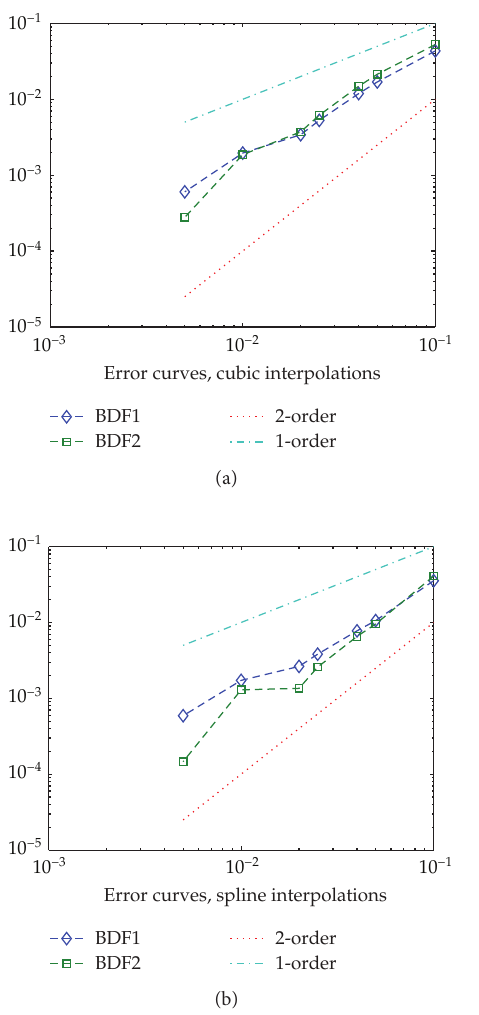
Figure 1: 𝐸 𝑙 2 -error of BDF1 and BDF2 versus the time step Δ𝑡 in log-log scale, with 𝑇 = 𝜋/4 , 𝜈 = 1.00 × 10 −3 ; ℎ = Δ𝑡 = 0.1, 0.05, 0.04, 0.25, 0.02, 0.005 . CI are involved in (a) and CSI in (b).